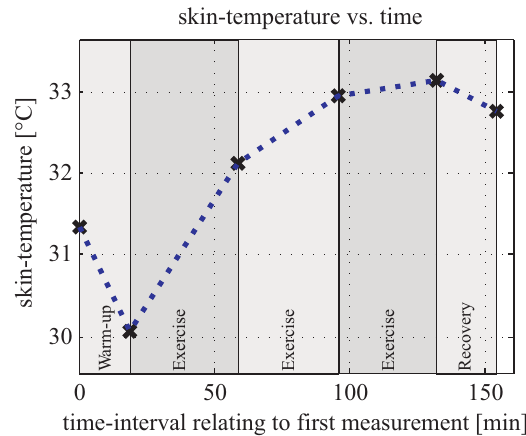
Fig.5: Temperature profile of athlete no. 10 measured on the hand.